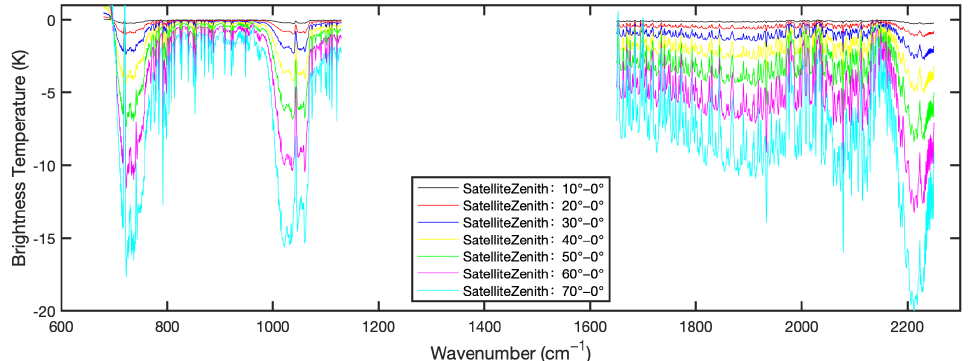
Figure 1. The simulated brightness temperature bias between different satellite zenith angles and 0° (American standard atmosphere).